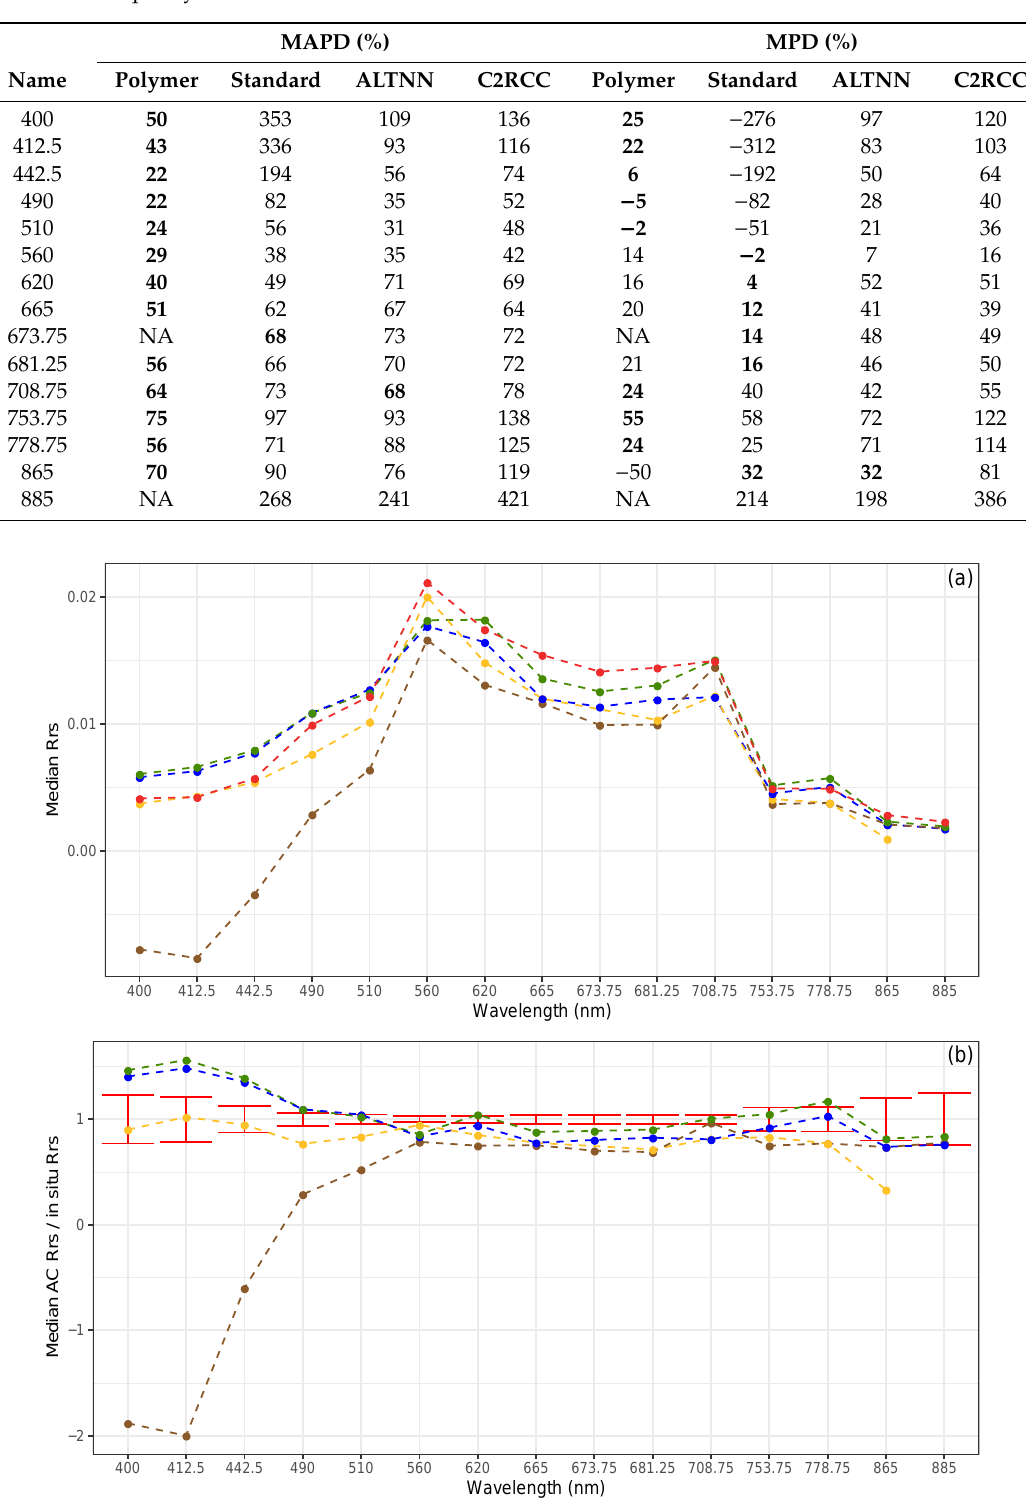
Figure 2. This is a figure, Schemes follow the same formatting. If there are multiple panels, they should Figure 10. Median R rs for each dataset ( a ) after including match-up stations only when all four AC be listed as: ( a ) Description of what is contained in the first panel. ( b ) Description of what is contained processors resulted in quality-controlled retrieval. The lower panel ( b ) is the ratio between median AC in the second panel. Figures should be placed in the main text near to the first time they are cited. A R rs to median in situ R rs and the median in situ uncertainty at every caption on a single line should be centered.